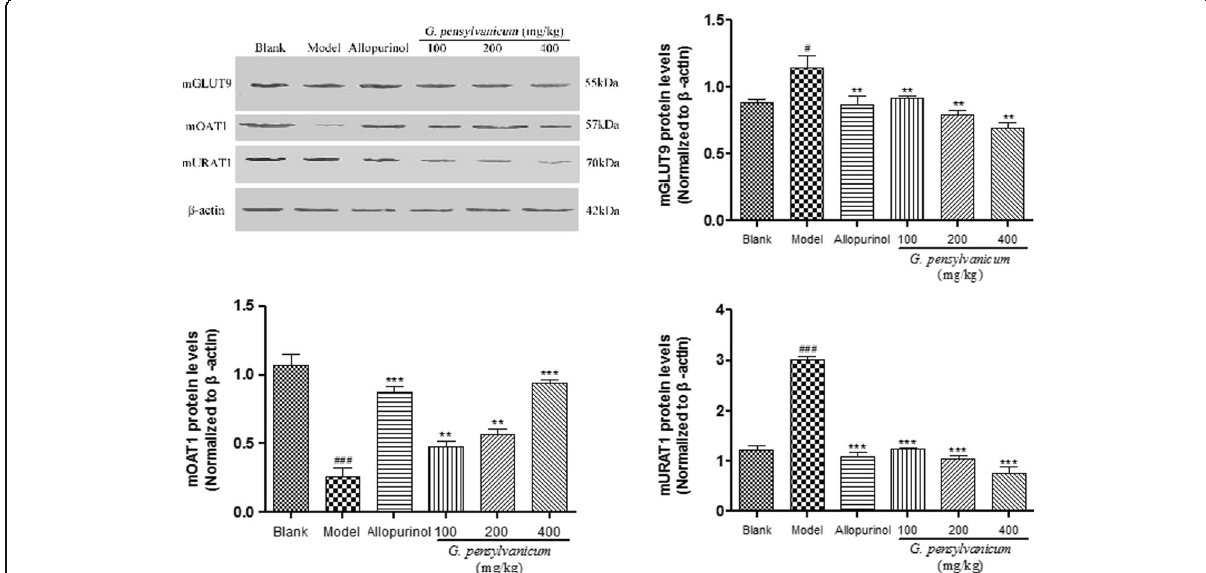
Fig. 3 Effects of G. pensylvanicum and Allopurinol on protein expression of mGLUT9, mOAT1 and mURAT1 in renal tissues in hyperuricemia mice by Western blot analysis. N = 10 per group. ## p < 0.01, ### p < 0.001 compare with blank; ** p < 0.01, *** p < 0.001 compare with model